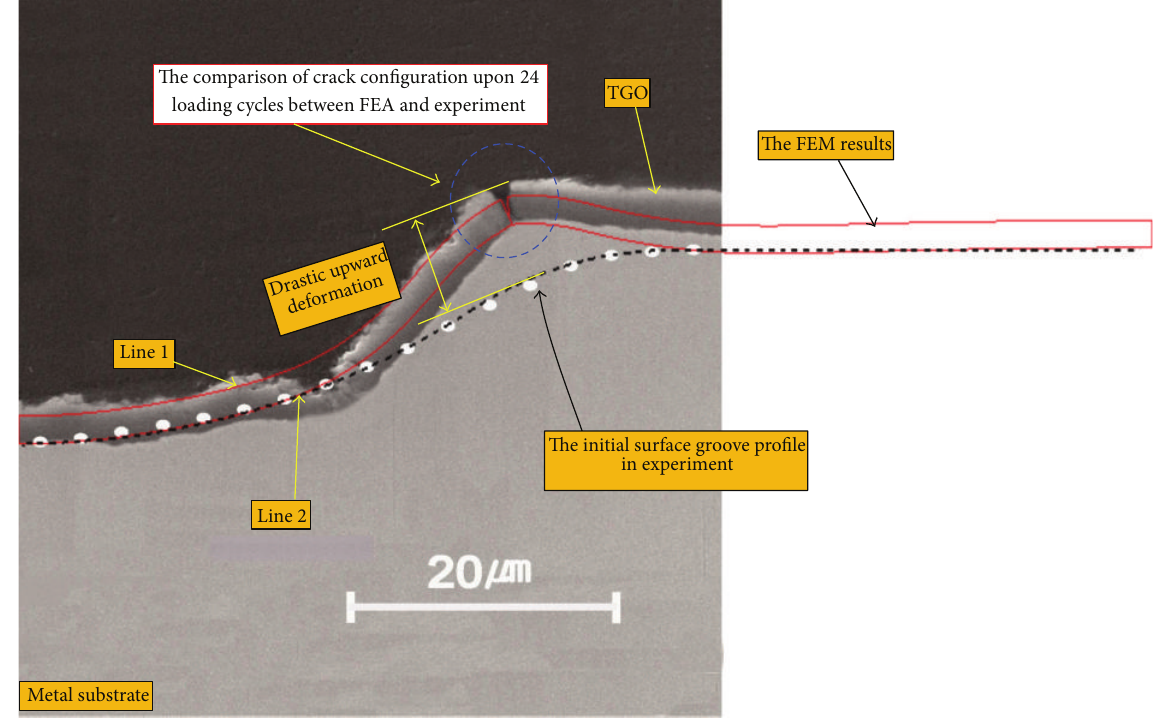
Figure 15: The comparison of TGO final deformation profile between FEA result and experimental